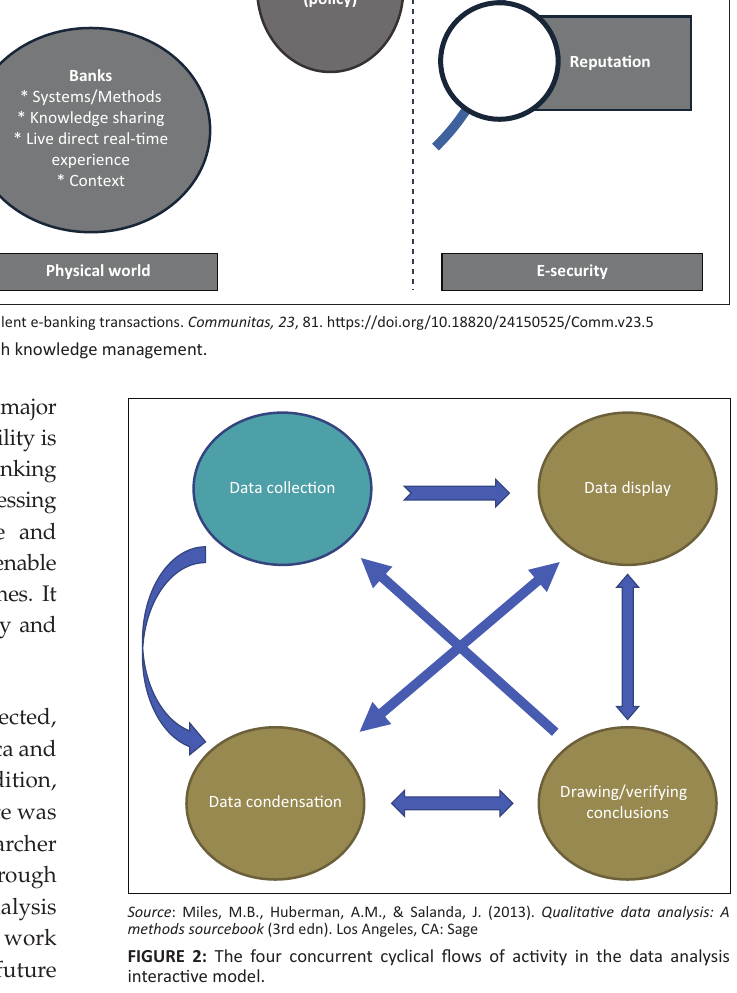
FIGURE 2: The four concurrent cyclical flows of activity in the data analysis interactive model.